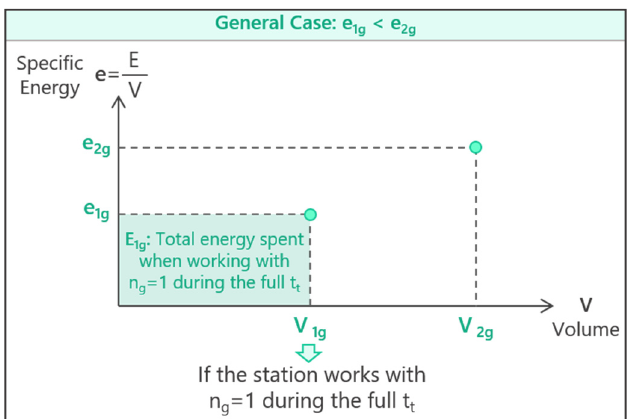
Figure 2. General case. Specific energy and the volume of pumped water. The energy consumed by the system when 1 group of pumps E 1g is working the whole time t t is obtained as the blue area.